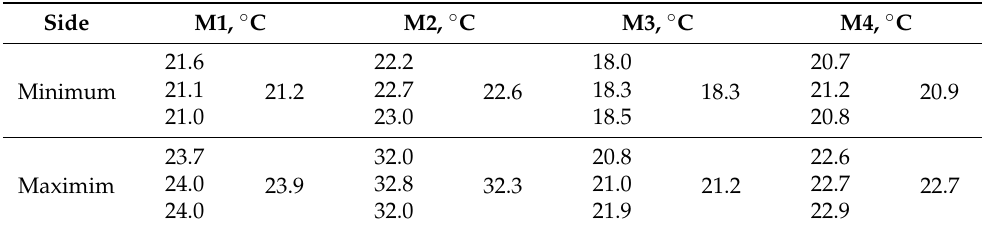
Table 2. The results of minimum and maximum temperature measurements on the entire surface of briquettes after briquetting.